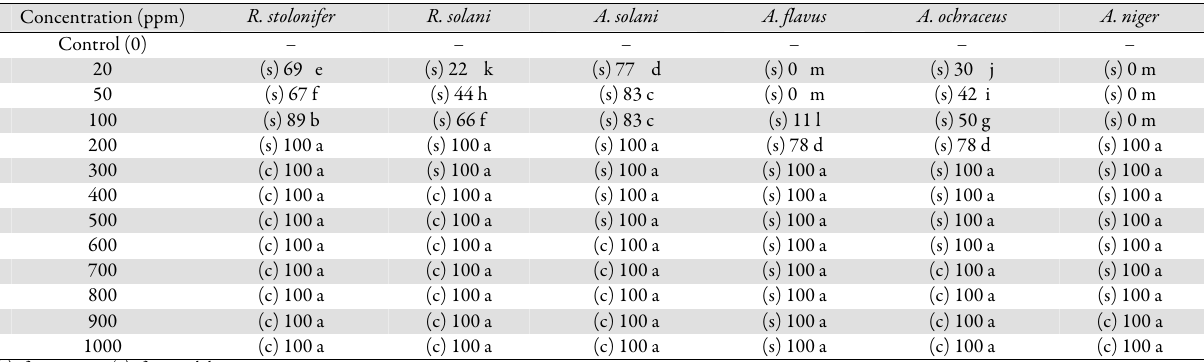
Fig. 1. Effect of different concentrations of Zataria multiflora essential oil on the inhibition percentage of fungus Alternaria solani , Rhizoctonia solani , Rhizopus stolonifer , Aspergillus flavus , Aspergillus ochraceus and Aspergillus niger . Different letters above columns indicate significant differences according to Duncan’s multiple range tests at P ≤ 0.01